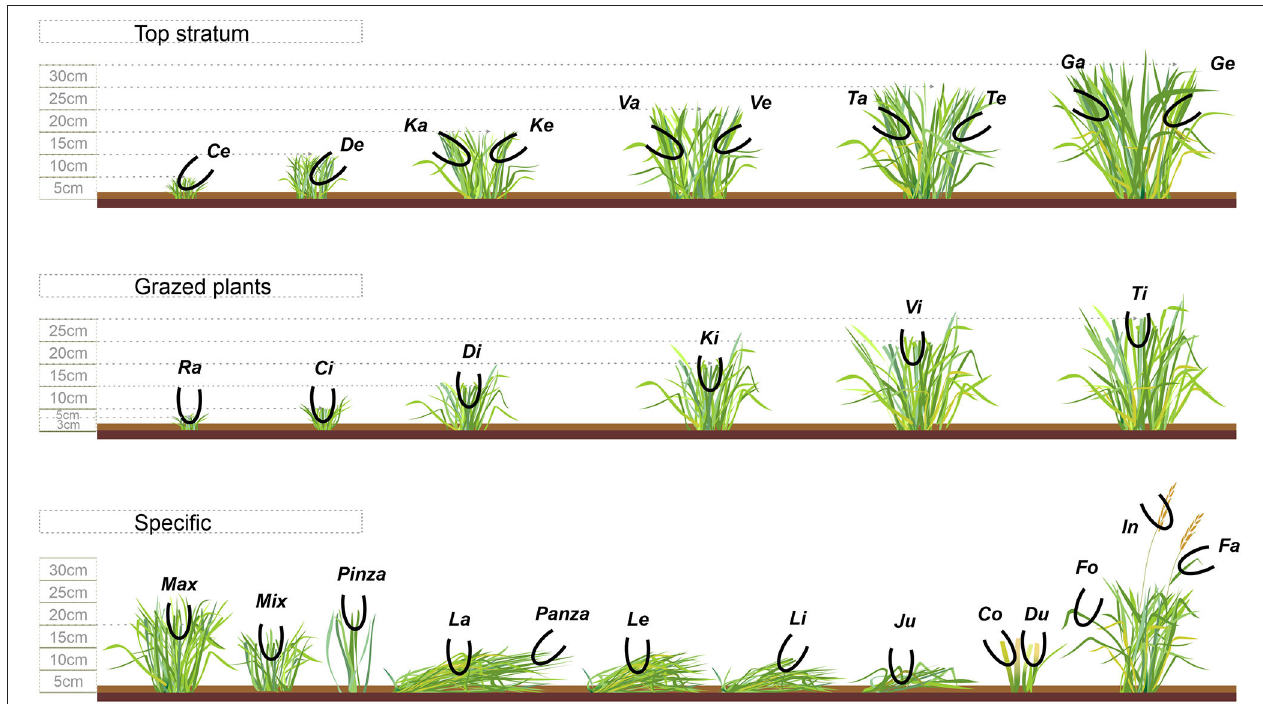
FIGURE 2 | Bite-code grid of sheep grazing vegetative Italian ryegrass pastures under contrasting grazing management strategies (RN and RT) in rotational stocking. The pictogram illustrates the bite types classified into three categories: top stratum, grazed plants or specific. Among the bites performed on “top stratum” are those coded with the consonants “C, D, K, V, T and G,” indicating plants of around 5, 10, 15, 20, 25 and 30cm ( ± 2.5cm), respectively; yet, the vowels “a” and “e” after these consonants indicate, respectively, “dense” and “less dense” bites ( ≥ 4 or ≤ 3 intact leaf laminas, respectively). Among the bites performed on “grazed plants” are those coded with the vowel “i” after the consonants, which also indicates leaf laminas with presence or not of stems; the bite “Ra,” within this category, is performed on plants of ≤ 3cm with minimum or no presence of leaf laminas. Among the “specific” type of bites, the bite “Max” is allocated on both grazed and intact leaf laminas, with the presence or not of stem, on plants with ≥ 15cm; the bite “Mix” is similar, but on plants with ≤ 15cm; the bite “Pinza” is allocated at the tip (superficial) of a single or no more than two intact or grazed leaf laminas, and at any sward height; the bite “Panza” is also a superficial bite, but on lying plants; the bite “La” is allocated on 2-to-3 lying intact leaf laminas with ≥ 20cm length, while the bite “Le” is similar, but on plants with ≤ 20cm length; the bite “Li” is allocated on lying plants gathering 2–3 grazed leaf laminas of any horizontal length; the bite “Co” and “Du” are performed on one and two defoliated stems, respectively, on plants with 5–15cm; the bite “Fo” is performed on a single intact or grazed leaf lamina within the canopy; the bite “Fa” is performed on the leaf lamina below the inflorescence, intact or grazed; the bite “In” is allocated on the inflorescence; the bite “Ju” is allocated on a trampled plant, in which animals manipulate and gather 2–4 intact or grazed leaf